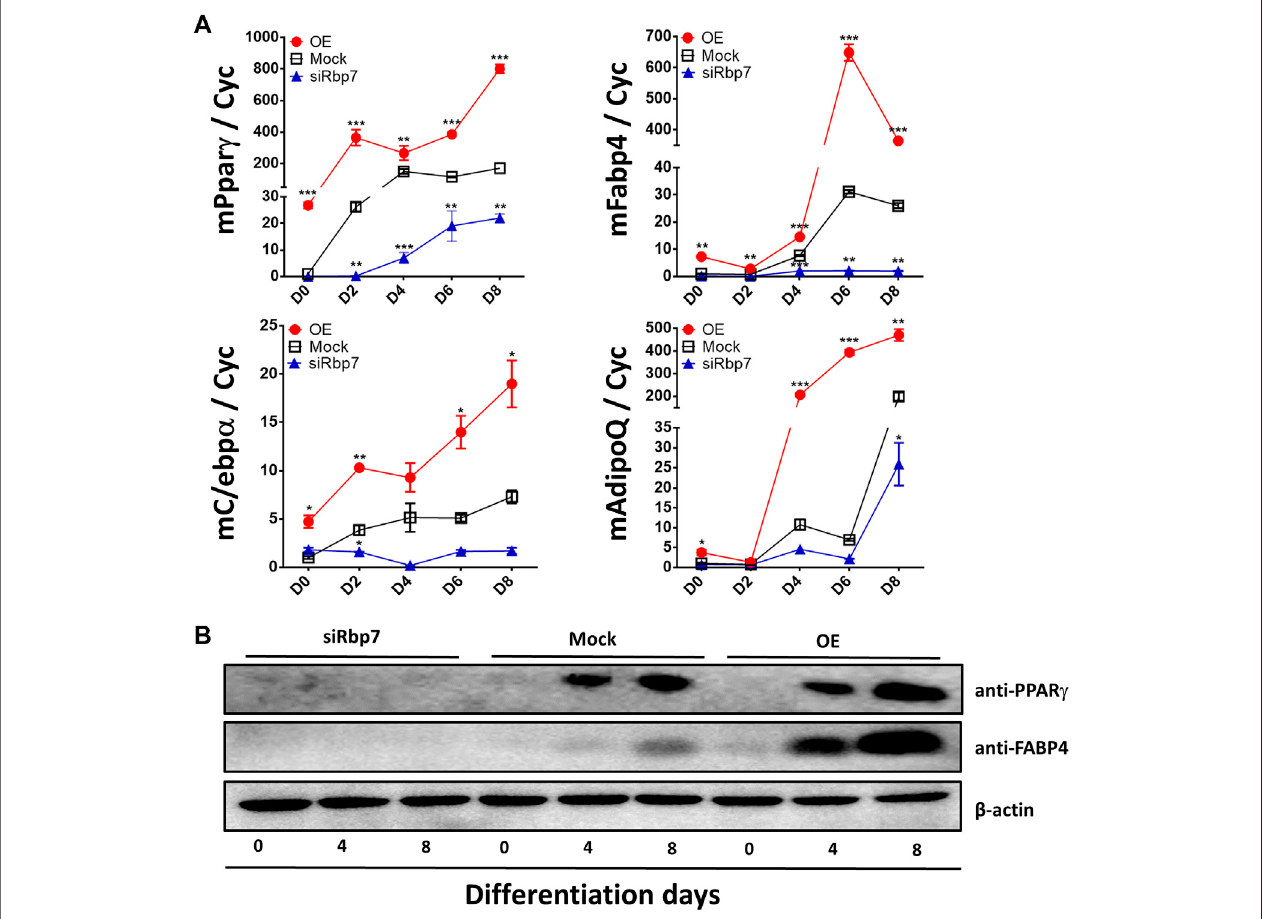
FIGURE4| Effects ofmodulation ofRbp7 expression on expression ofadipocyte markers. (A) Quantitative analysisofadipocyte markers on differentiated 3T3-L1 cells. Cyc wasusedashousekeepingcontrol.Redcircle:OEgroup;Blackrectangular:Mockcontrol;Bluetriangle:siRbp7group.D0-8:preadipocytedifferentiationday. Valuespresentmeans±SEM. (B) Westernblotanalysisofadipocytedifferentiationmarkers.Thedatawerecomparedoneachtimepointamongdifferentgroups(OEvs. Mock vs. siRbp7) to analyze signi fi cant difference. One-way ANOVA was used followed by Tukey ’ s multiple comparisons test. * p < 0.05, ** p < 0.01, *** p < 0.001.